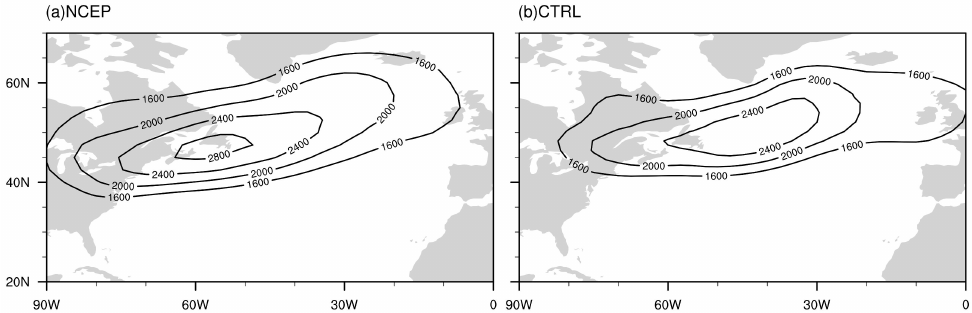
Figure 8. Climatological 500-hPa Atlantic storm track (contour; units: m 2 ) in spring in: ( a ) the atmospheric reanalysis; and ( b ) CTRL. The contour interval is 400 m 2